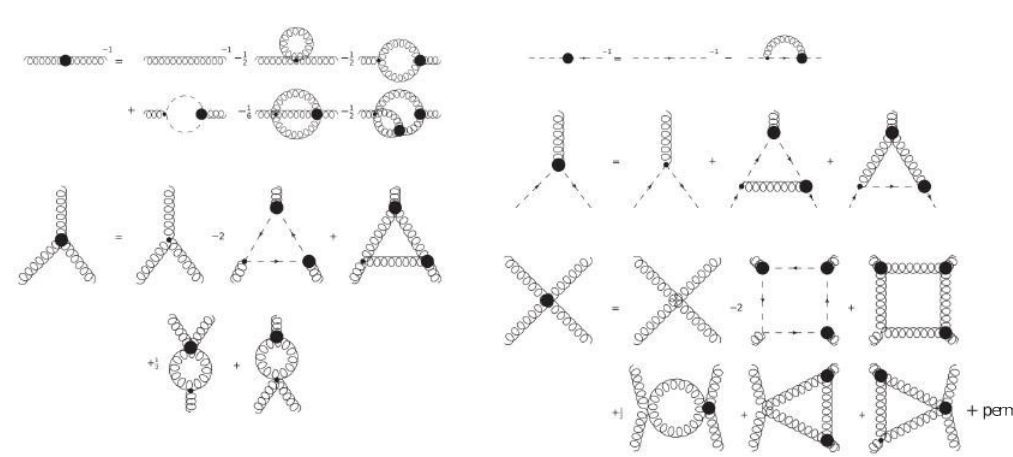
Figure 1. The employed truncated system of equations. Internal propagators are dressed, and thick blobs denote dressed vertices, wiggly lines gluons, and dashed ones ghosts.